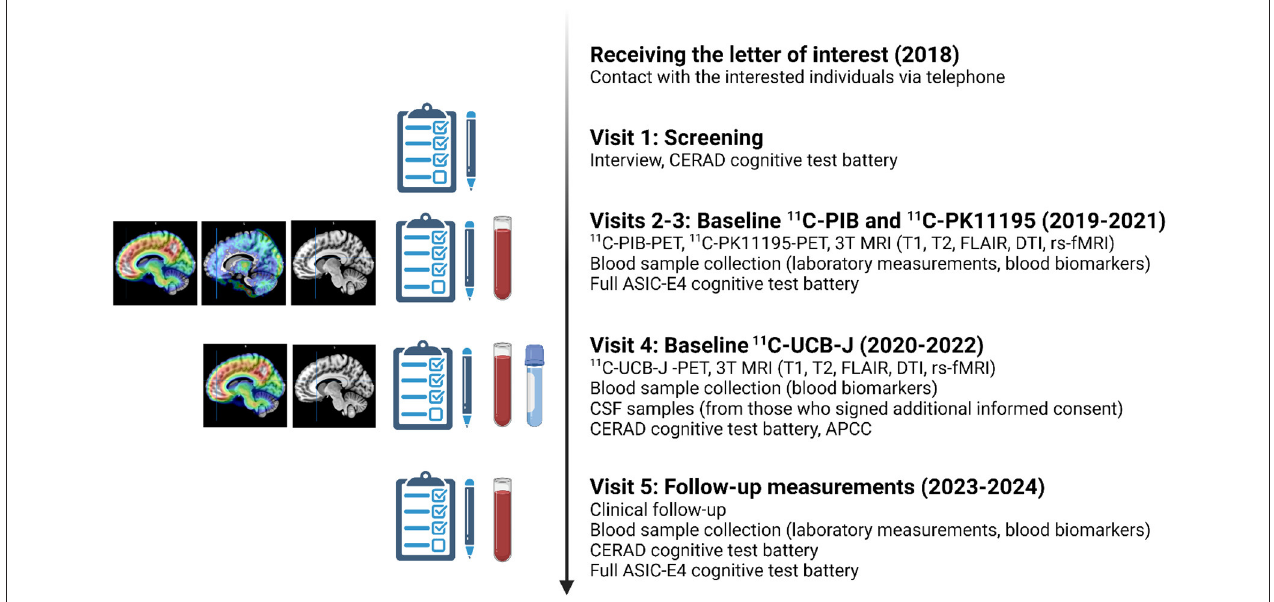
FIGURE 3 | Planned study visits during the ASIC-E4 study. All included ASIC-E4 participants will visit Turku PET Center and Turku University Hospital 3–5 times during years 2019–2022. In addition, all will be invited to a follow-up visit approximately 4 years from screening (starting 2023). APCC, Alzheimer’s Prevention Initiative Composite Cognitive Test Score; CERAD, Consortium to Establish a Registry for Alzheimer’s Disease; CSF, cerebrospinal fluid; DTI, diffusion tensor imaging; rs-fMRI, resting state functional magnetic resonance imaging; FLAIR, fluid attenuated inversion recovery PET, positron emission tomography; MRI, magnetic resonance imaging. The figure was created with